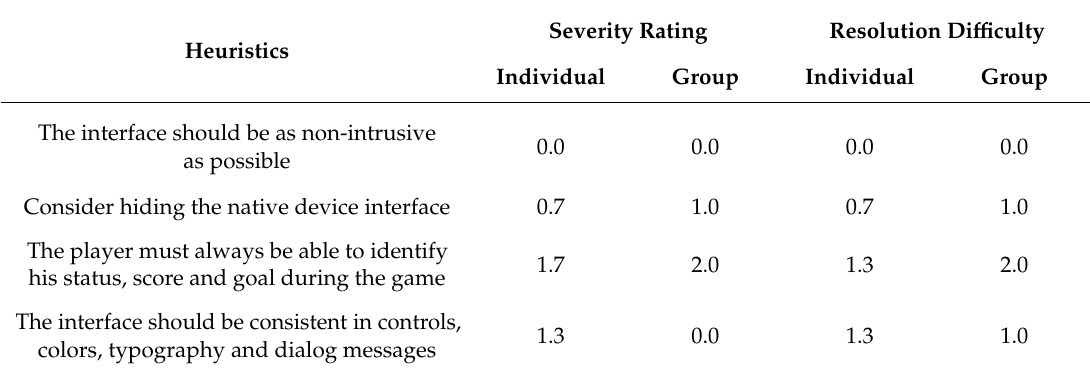
Table 8. Heuristics analysis of the game’s feedback